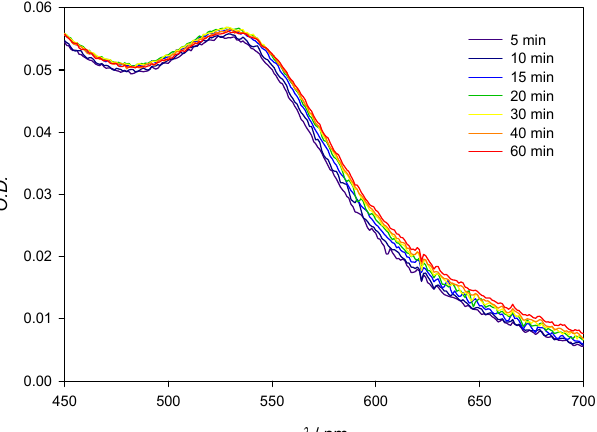
Figure 9. Experimental spectra of 5 nm AuNPs in the presence of Lys. [AuNPs] = 4 × 8.22 × 10 − 10 M; [Lys] = 4 × 10 − 4 M. M; [Lys] = 4 × 10 − 4 M.